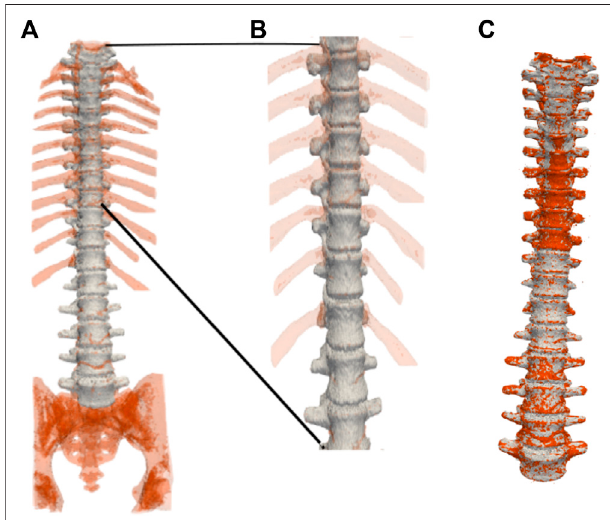
FIGURE 8 | Three-dimensional spine segmentation rendering. (A) : Shown in lightgreyisthe vertebrae region thatiscommon toboth,theground truth and the segmentation obtained by our method. The extra regions segmented such as the ribs, the coccyx and the sacrum, and other voxels in the spinal column, are shown in red. (B) : A zoomed-in image of the upper thoracic region. (C) : The segmented spine (shown in red) overlaid on top of the ground truth (shown in light grey) after cropping-out the regions manuallyusingITK-SNAP.Manualcroppingoftheextraneousregionssuchas the ribs, the coccyx and the sacrum after segmentation could be regarded as selecting a region of interest (ROI) before an input image is fed into an automated segmentation method (Lessmann et al., 2019; Sekuboyina et al., 2020). For example, in Lessmann et al. (2019), images are cropped to restrict the fi eld of view of the vertebrae that were not included in the reference segmentation in order to avoid training the network with vertebra voxels incorrectly labeled as background voxels. In contrast, we feed in the entire image, consisting of the entire FoV, to our algorithm, which then produces the desired segmentation ofthe spine. Our fl ow-based segmentation approach is designed to also segment the ribs, and the sacrum when available. Therefore, in order to compute volume and surface-based quantitative measurements of the vertebral segmentations for which the ground truth segmentations are available, we crop out the regions such as the ribs, and the sacrum using ITK-